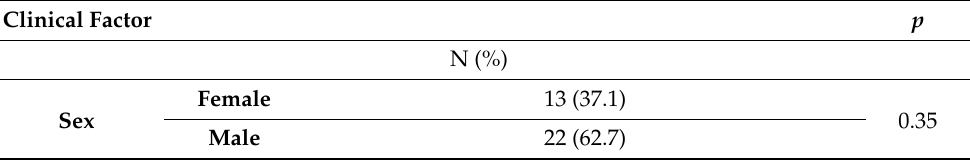
Table 2. The impact of different factors on VISTA mRNA level. Clinical characteristics of the group considered 35 patients with